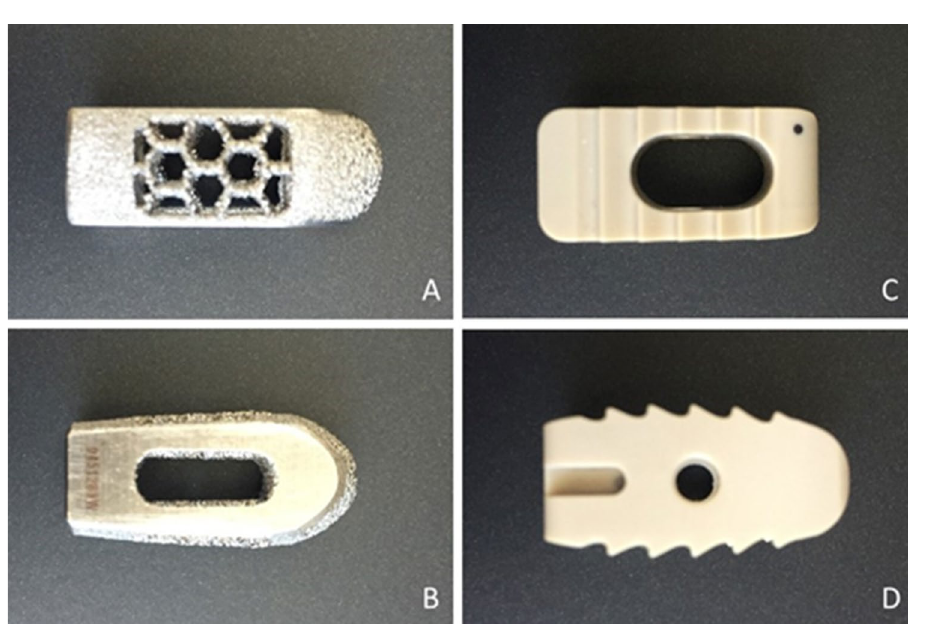
Figure 3. Superior and lateral views of Fuse cage ( A,B ) and Capstone cage ( C,D